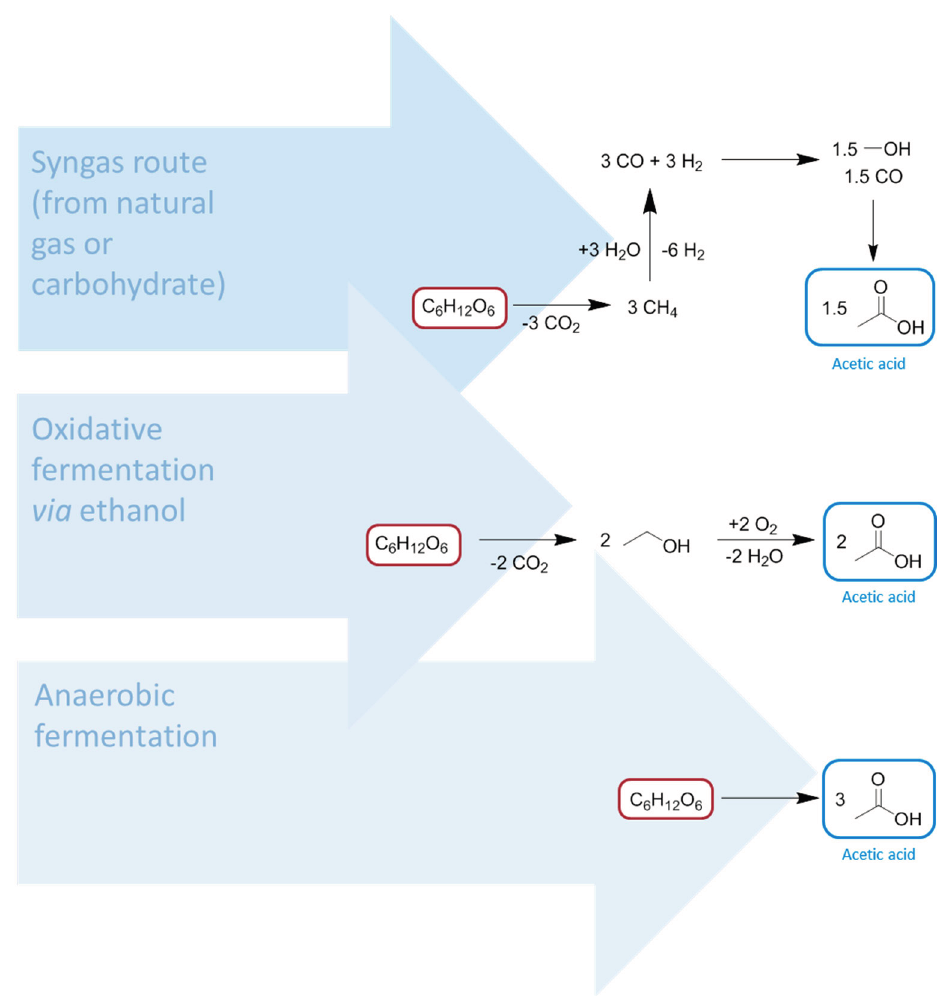
Figure 9. Stoichiometric reaction schemes for three approaches to the biosynthesis of acetic